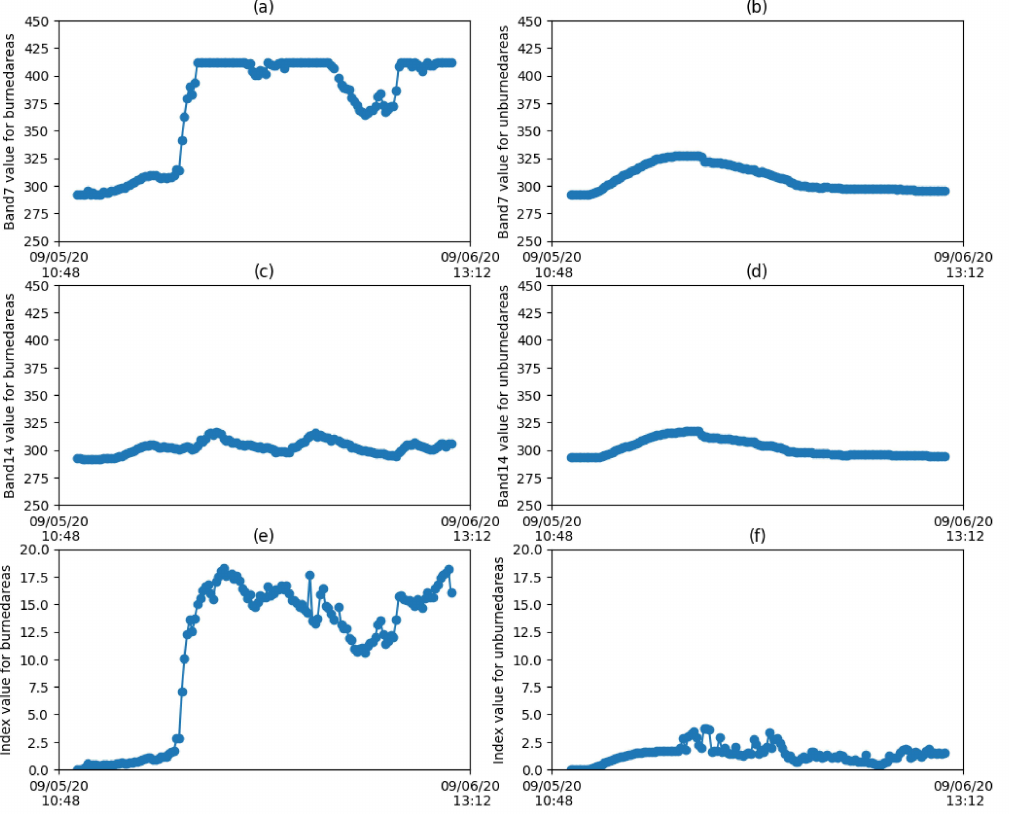
Figure 4. Inspections on time series of Band 7 ( a ), Band 14 ( c ), and Normalized difference value ( e ) of Burned area and time series of Band 7 ( b ), Band 14 ( d ), and Normalized difference value ( f ) of Unburned area. Study area: Creek Fire, California between 5 September 2020 12:00 to 6